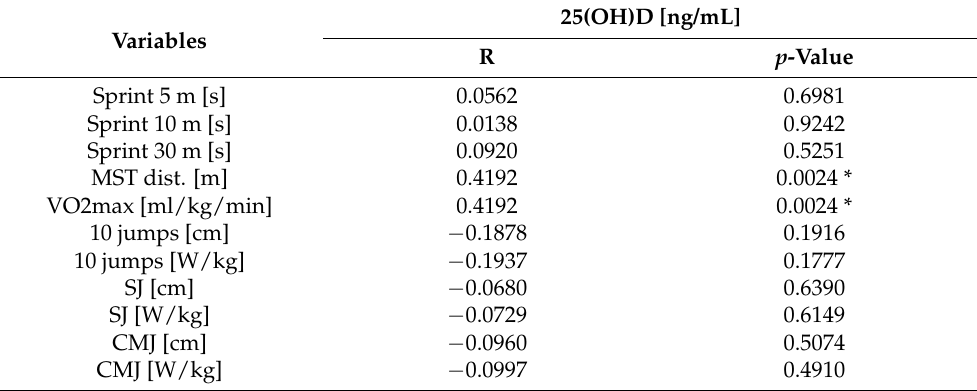
Table 3. Correlation between 25(OH)D concentration and physical fitness parameters in young soccer